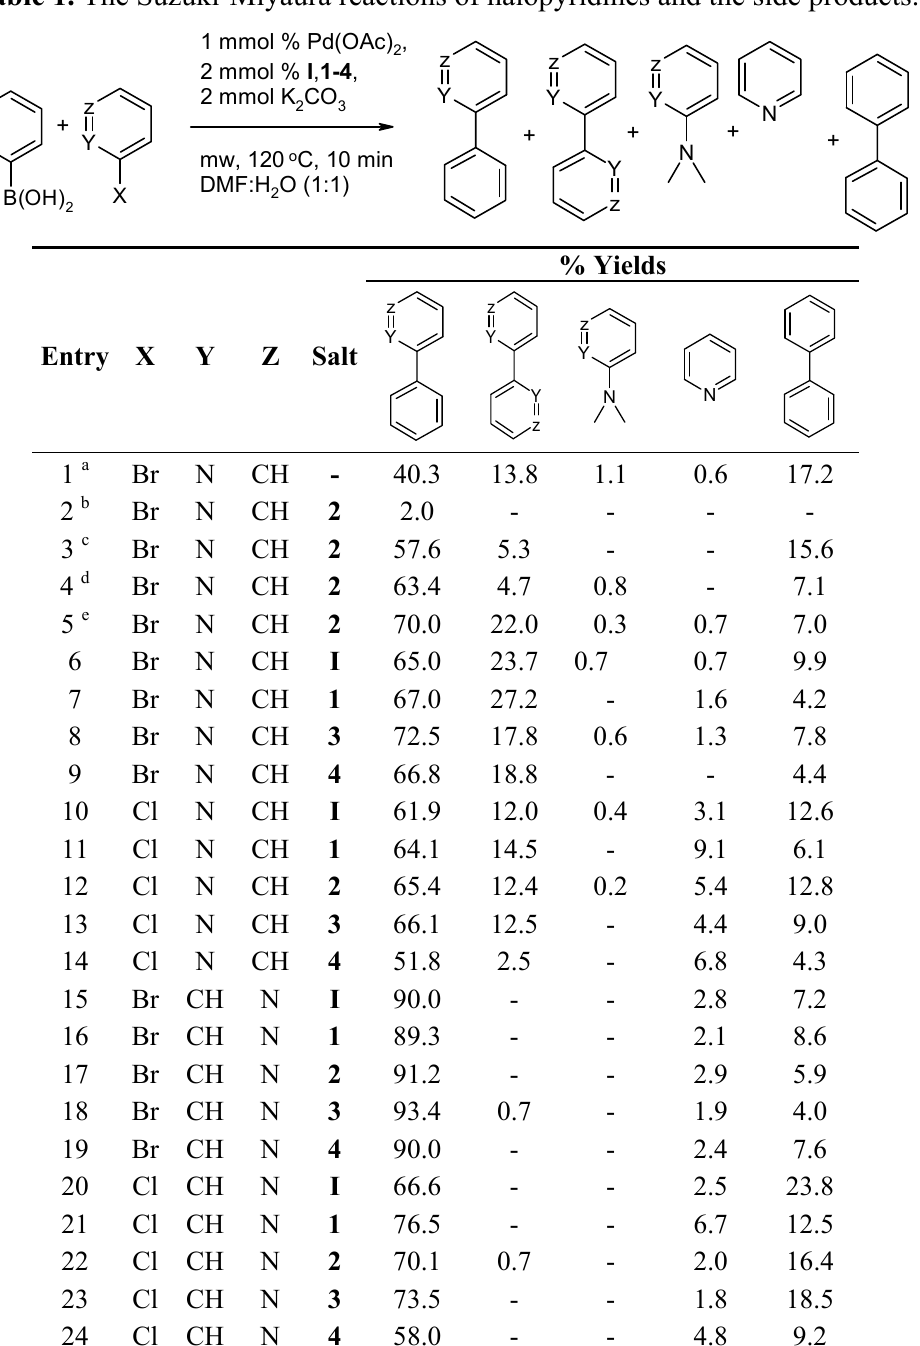
Table 1. The Suzuki-Miyaura reactions of halopyridines and the side products.